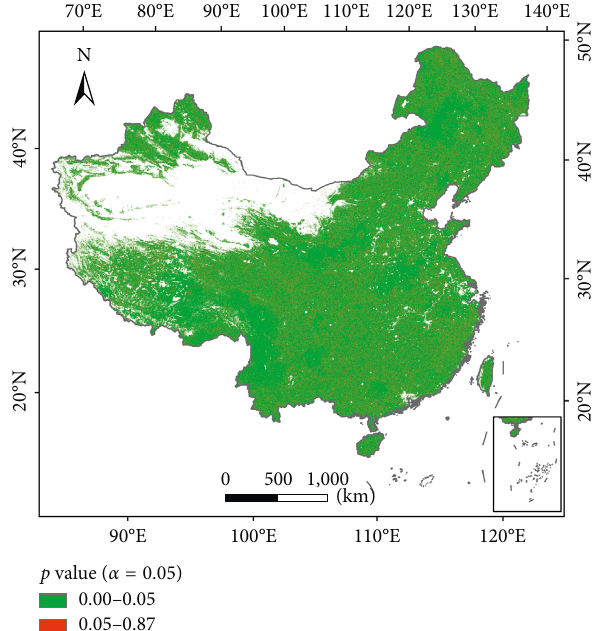
Figure 2: The p value of the linear trend of China’s vegetative